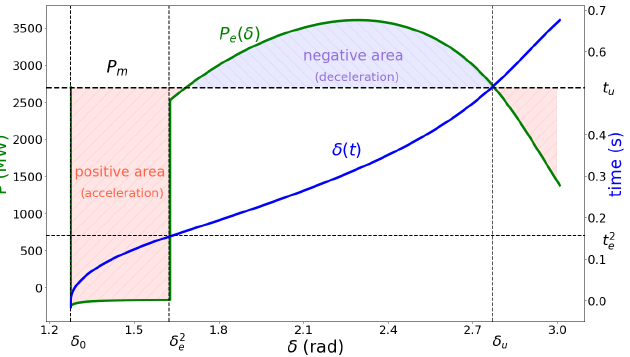
Figure 4. OMIB δ − P and t − δ curves defined by the swing equation for a first-swing stable case.